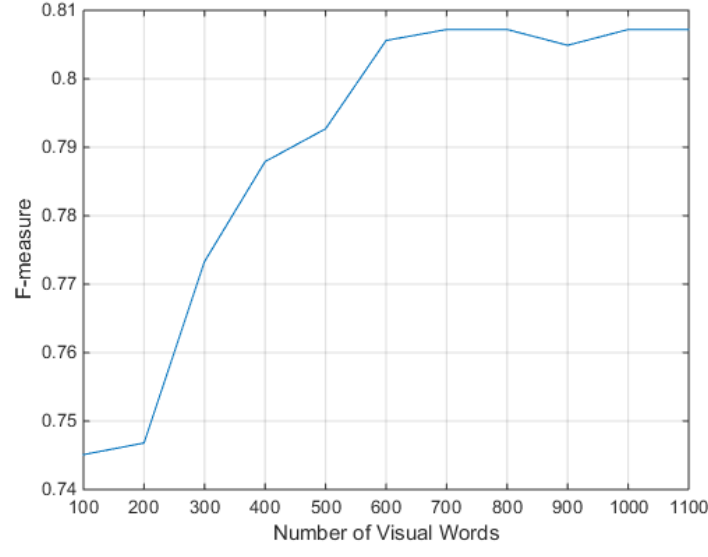
Figure 11. Influence of the number of visual “words” for the F-measure of the BOVW method.